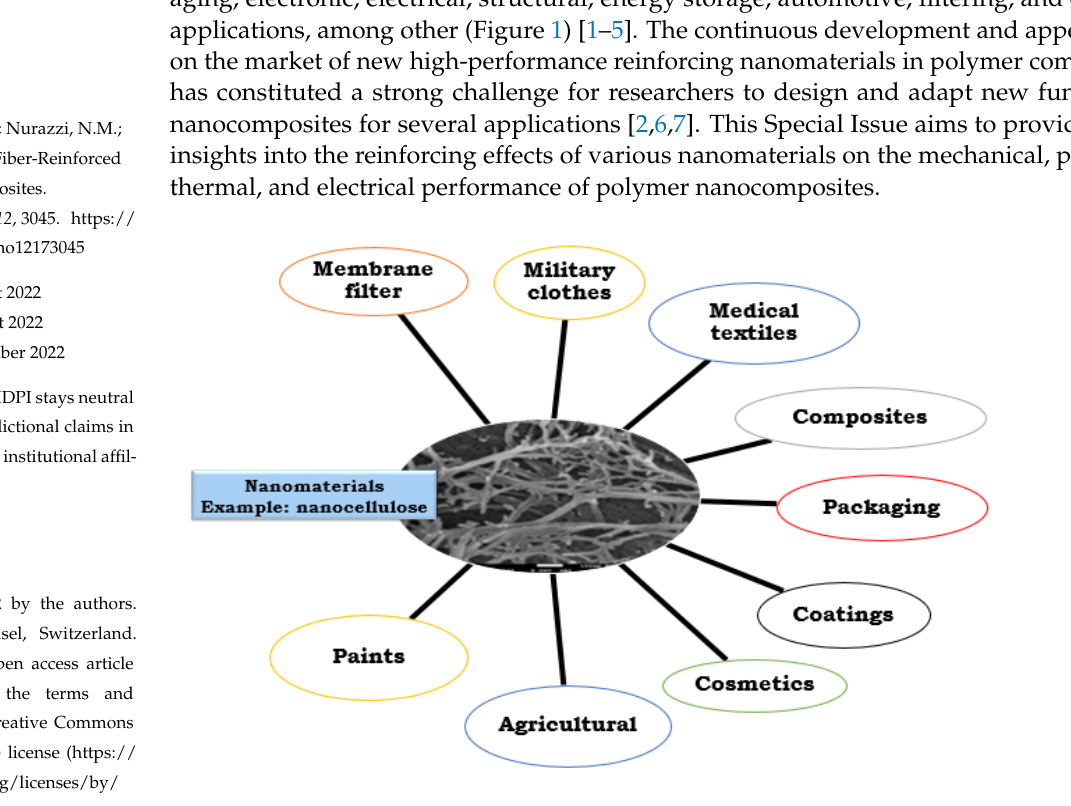
Figure 1. Various applications of nanomaterials.